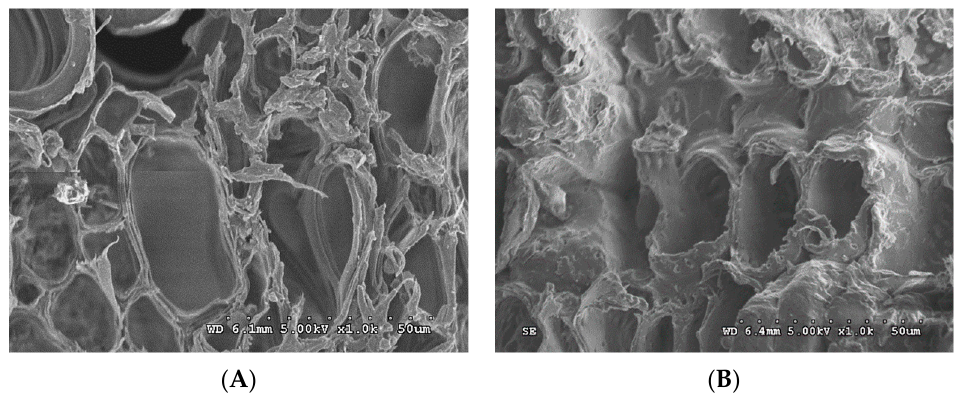
Figure 3. Scanning electron microscopic images of top view ( A ) and cross-sectional view ( B ) of dried rattan pieces at a magnification of 3000×.